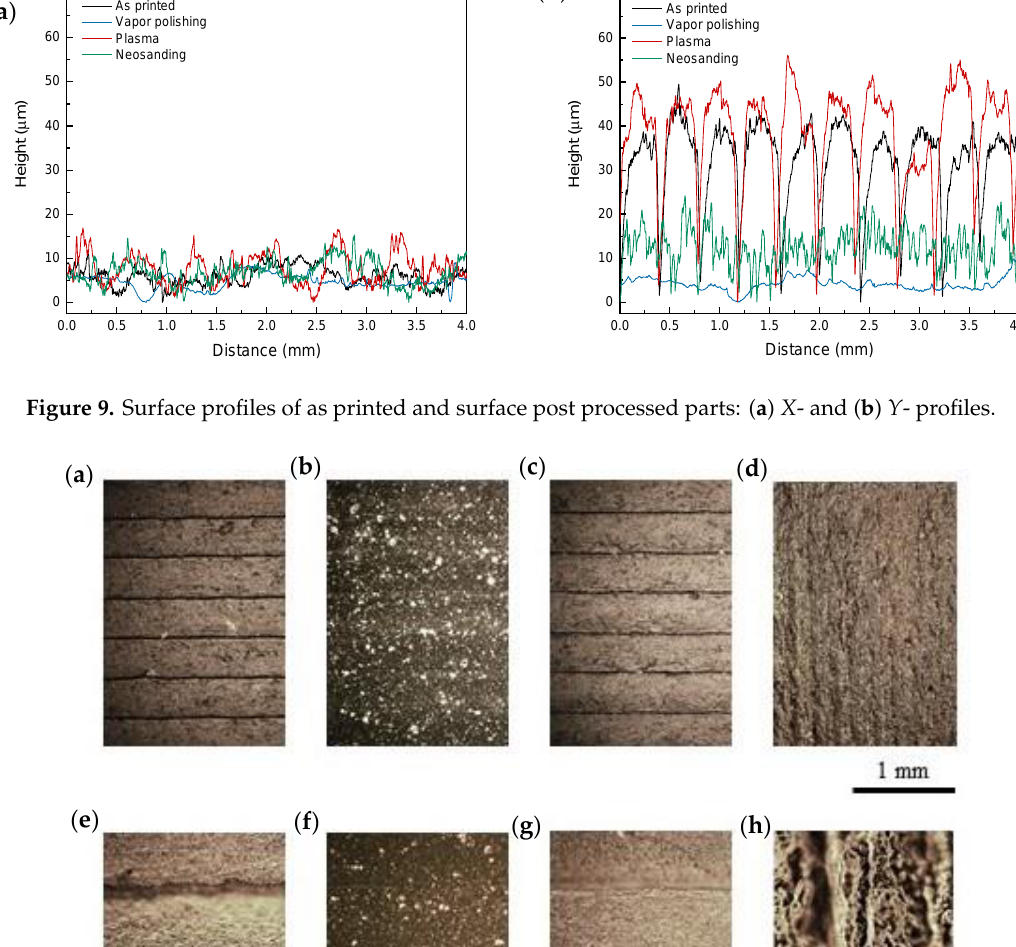
Figure 8. Surface electrical conductivity along X -axis and Y -axis of P3.4 printed parts.